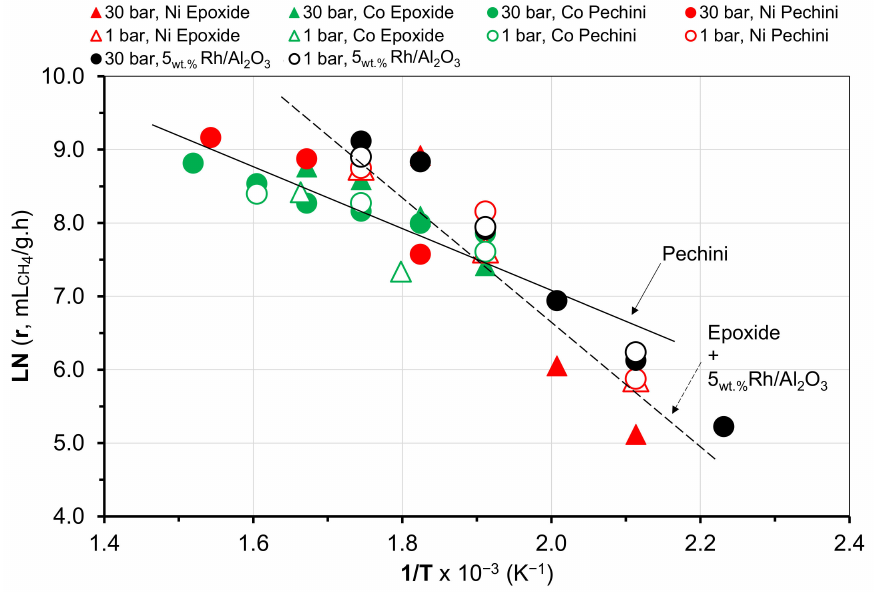
Figure 11. Relationship between reaction rates to temperature linearized in coordinates of the Arrhenius equation obtained for the catalysts prepared by the Epoxide addition and Pechini method and for the commercial rhodium catalysts (5 wt.% Rh/Al 2 O 3 ) used as